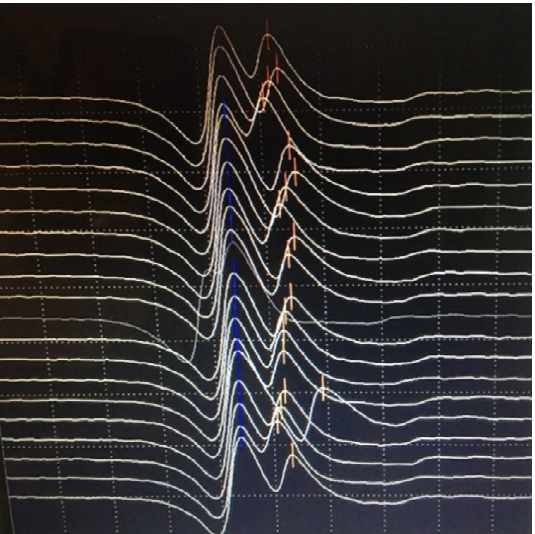
Figure 10. Abnormal jitter in the masseter muscle: cascade mode. Grid 0.5 mV by 0.3 msec.